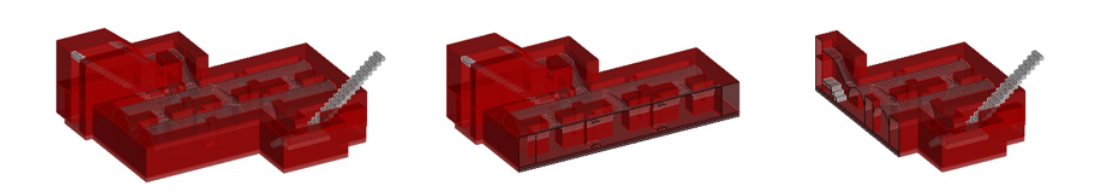
Figure 4. 3D reconstruction images of the refuge, showing cross sections in both directions.